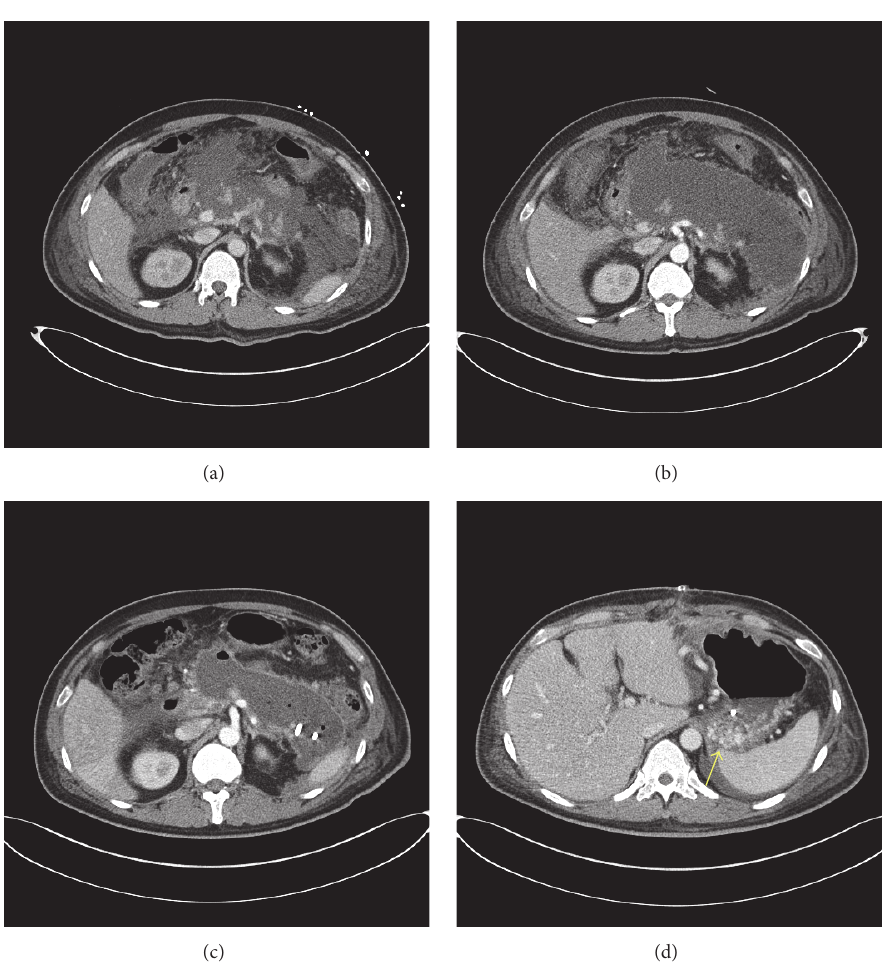
Figure 1: (a) Abdominal CT scan showed severe necrotizing pancreatitis. (b) Abdominal CT scan following 2 weeks of medical treatment. A huge pseudocyst was seen. A percutaneous drainage was performed. (c) Follow-up CT at 4 weeks after external drainage. The function of drain was poor and a huge pseudocyst was still seen. A necrosectomy and surgical drainage was performed. (d) CT scan at 1 week following the operation. Engorged submucosal veins were observed at gastric fundus.